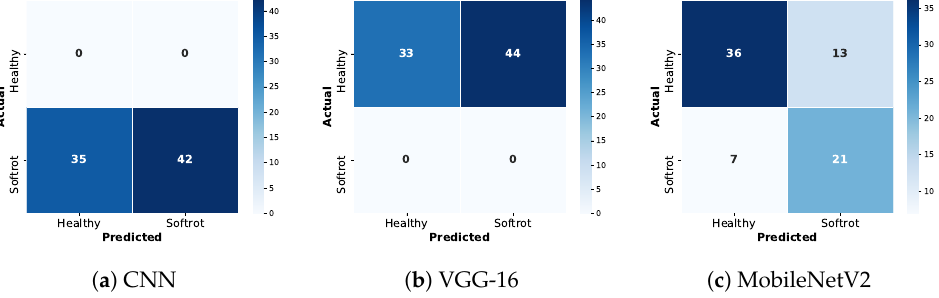
Figure 9. Confusion matrices on soft rot disease based on 77 validation images.